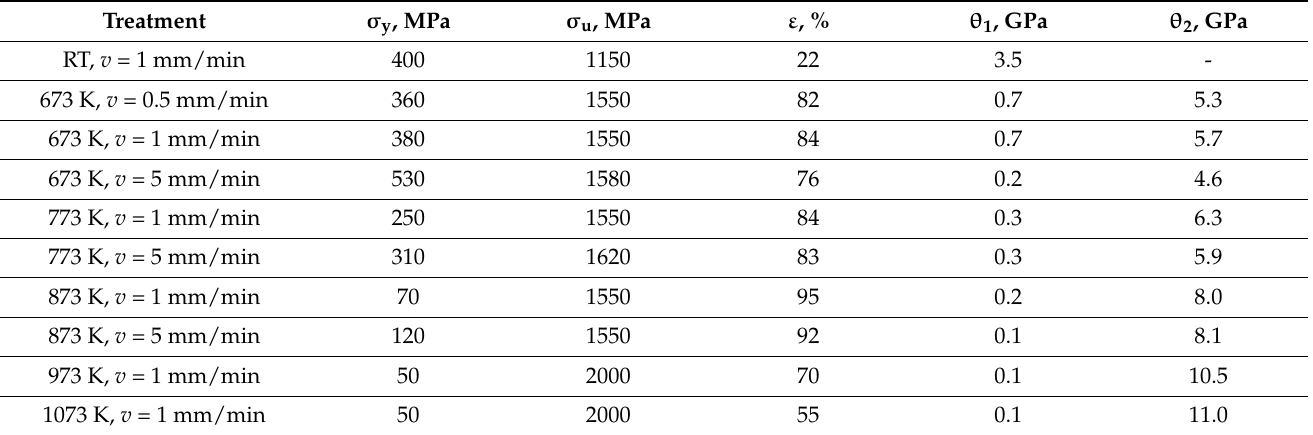
Table 5. Mechanical characteristics of the Cu-14Al-4Ni alloy after MPC at various temperatures and rates ( v